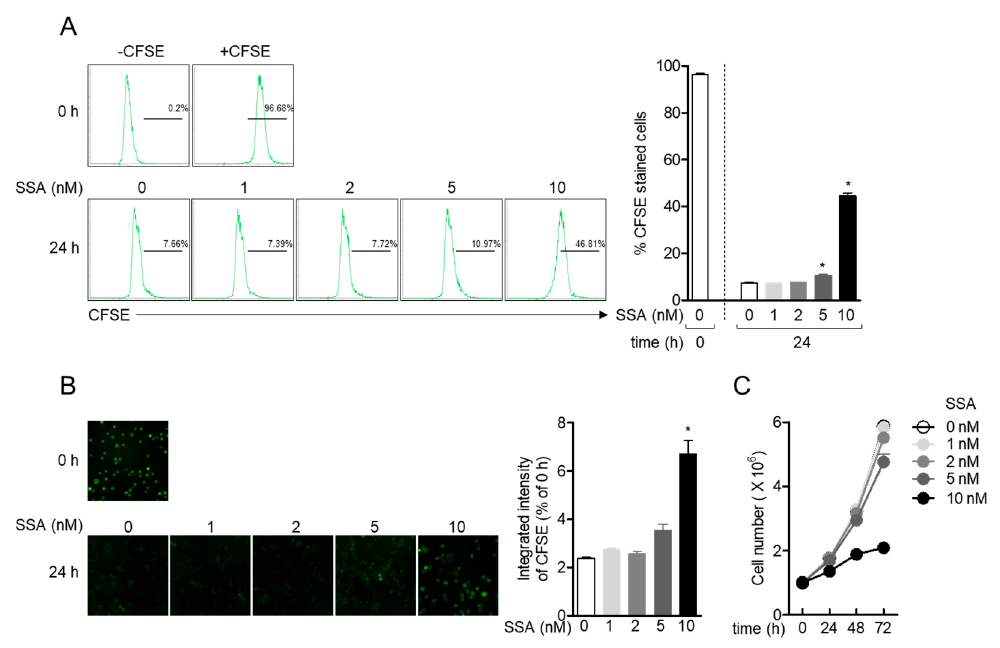
Figure 4. Treatment with 10 nM salinosporamide A reduces T cell proliferation. ( A , B ) Jurkat T cells pre-stained with 1 μ M CFSE for 30 min were treated with the indicated concentration of salinosporamide A (0–10 nM) for 24. The percentage of CFSE-positive cells were measured by flow cytometry ( A ), and microscopic fluorescence images and integrated CFSE intensity were determined using an IncuCyte imaging system ( B ). The black line refers to CFSE-positive cells according to the negative control (-CFSE). ( C ) The growth rate of Jurkat T cells treated with the indicated concentration of salinosporamide (0–10 nM) for 72 h was determined by counting the cell number every 24 h. The mean value of three experiments ± SEM is presented. * p < 0.05 between control cells.